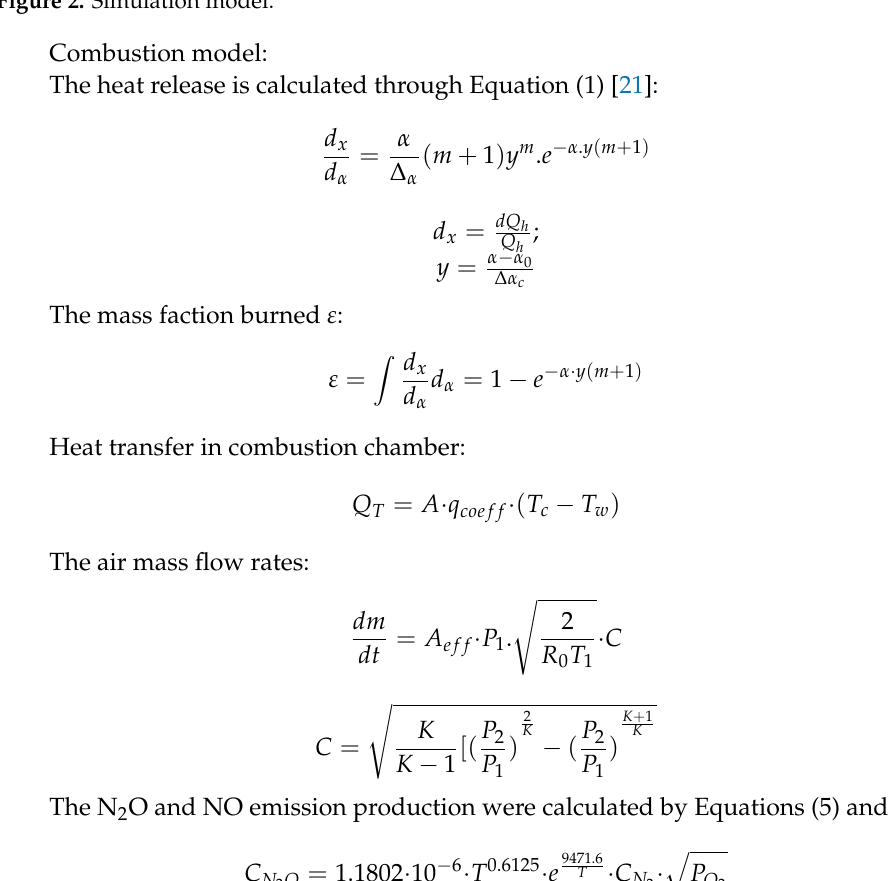
Figure 2. Simulation model.